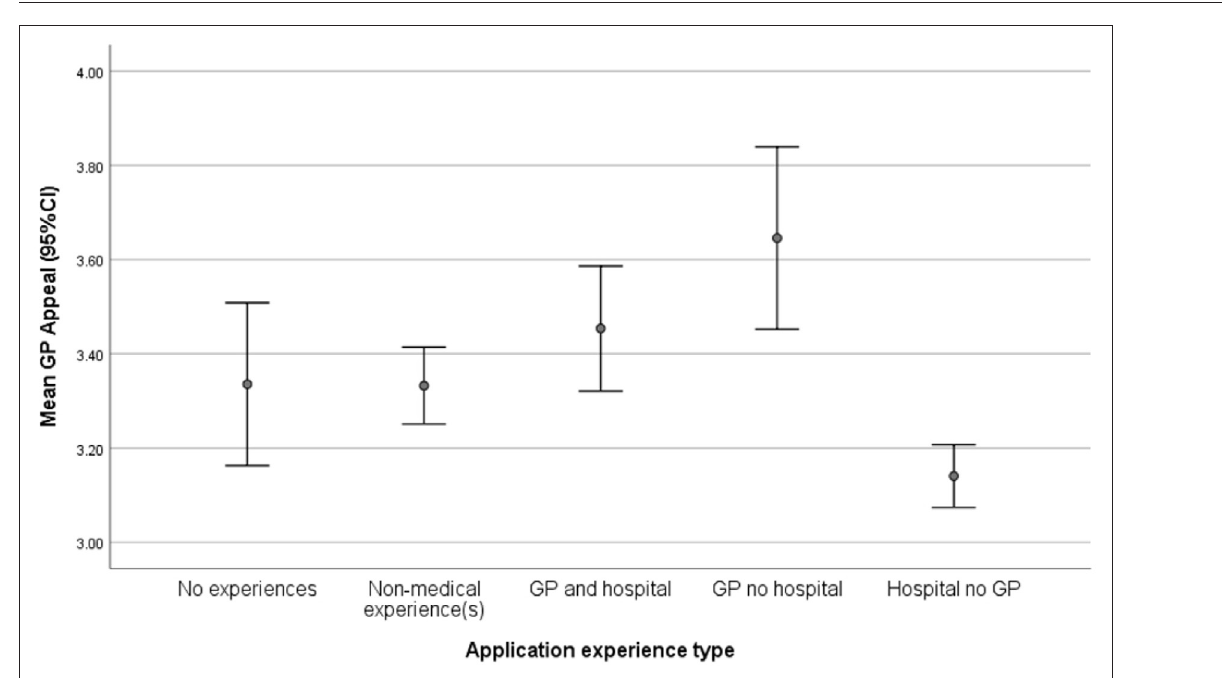
Figure 1 Mean general practice appeal by experience type. GP = general